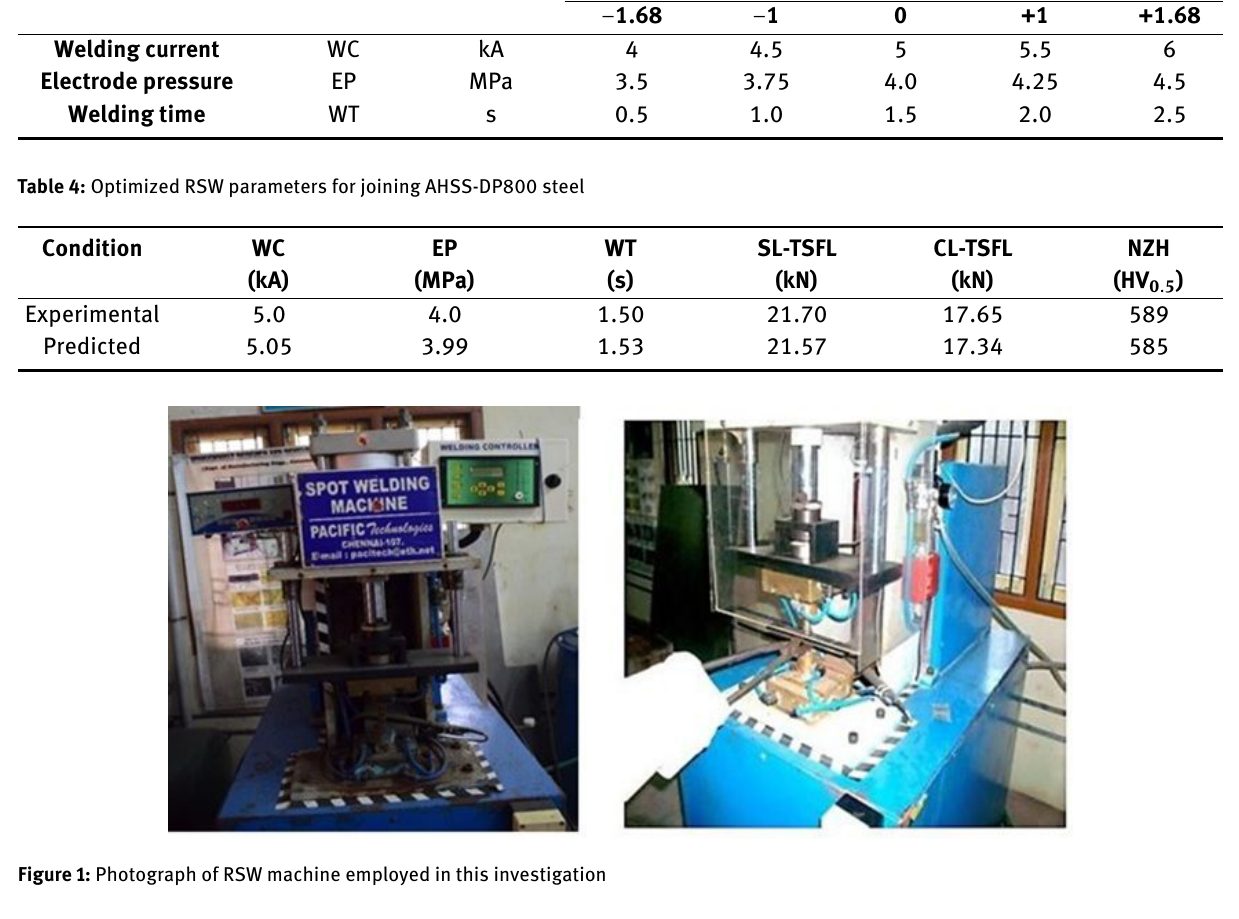
with 16 mm shank and 5 mm lid diameter respectively. The welding trials were performed to determine the working limits of process